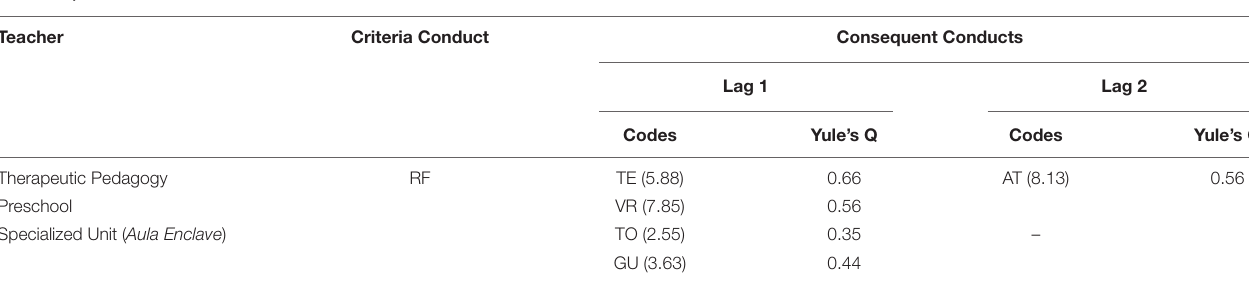
TABLE 8 | Motivation Function.